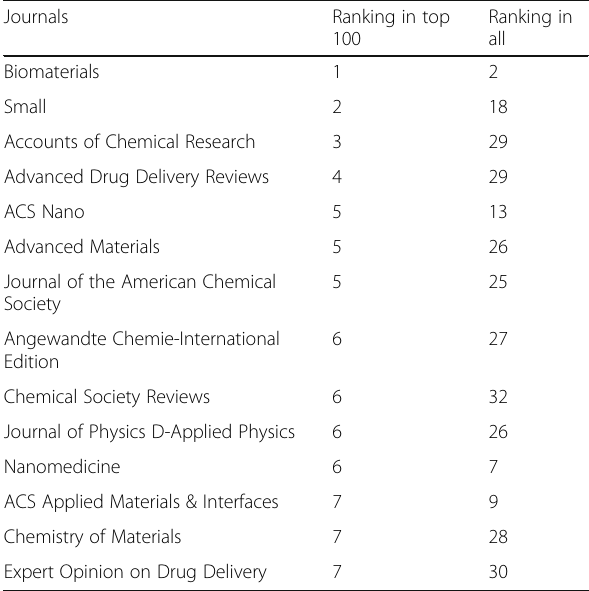
Table 5 Comparing top 100 best cited papers ’ journals with